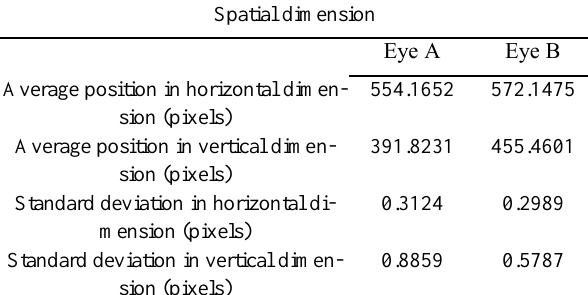
Noise measurement in both spatial and temporal dimension during the recording of eye tracking data using a pair of artificial